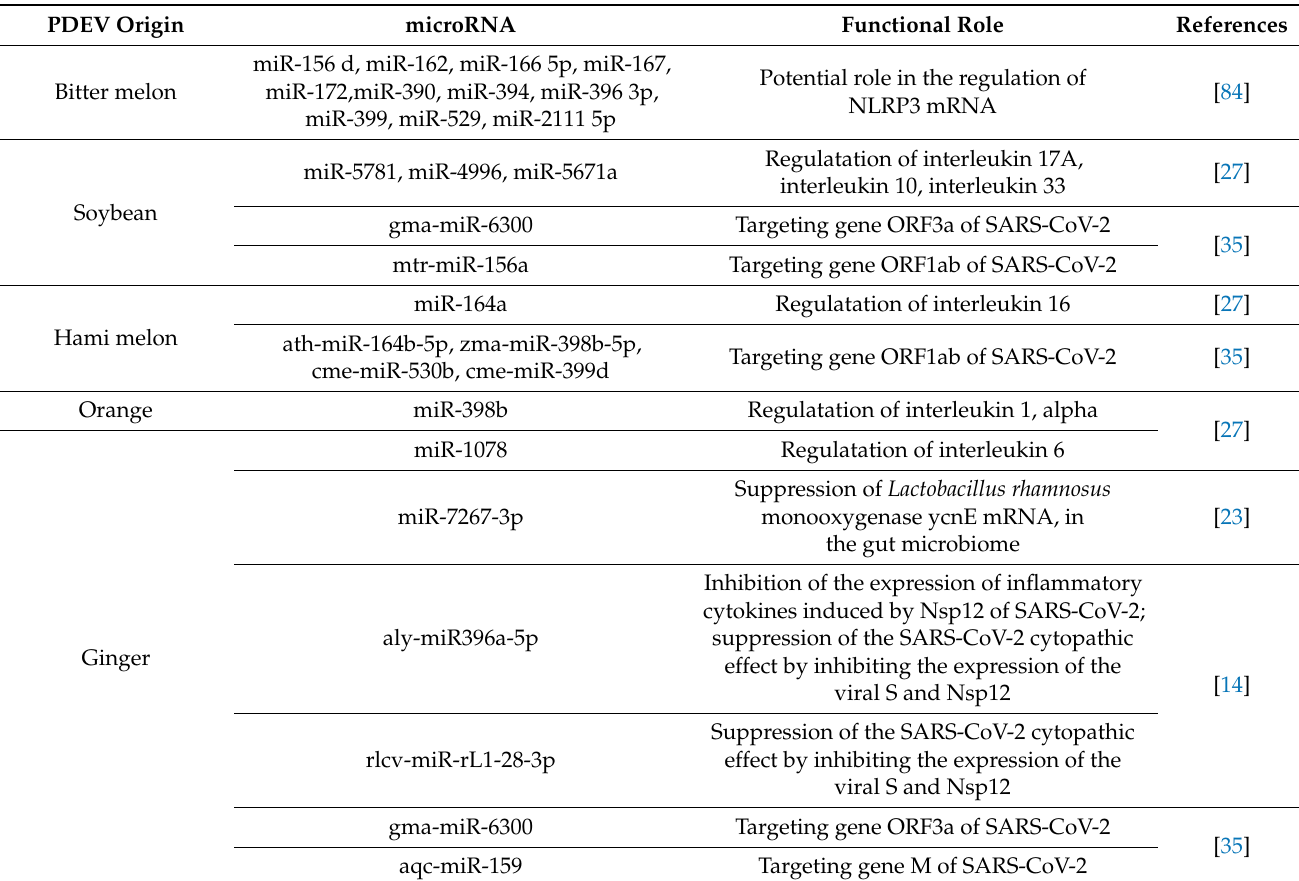
Table 1. Origin and functional role of microRNAs packed into different plant-derived extracellular